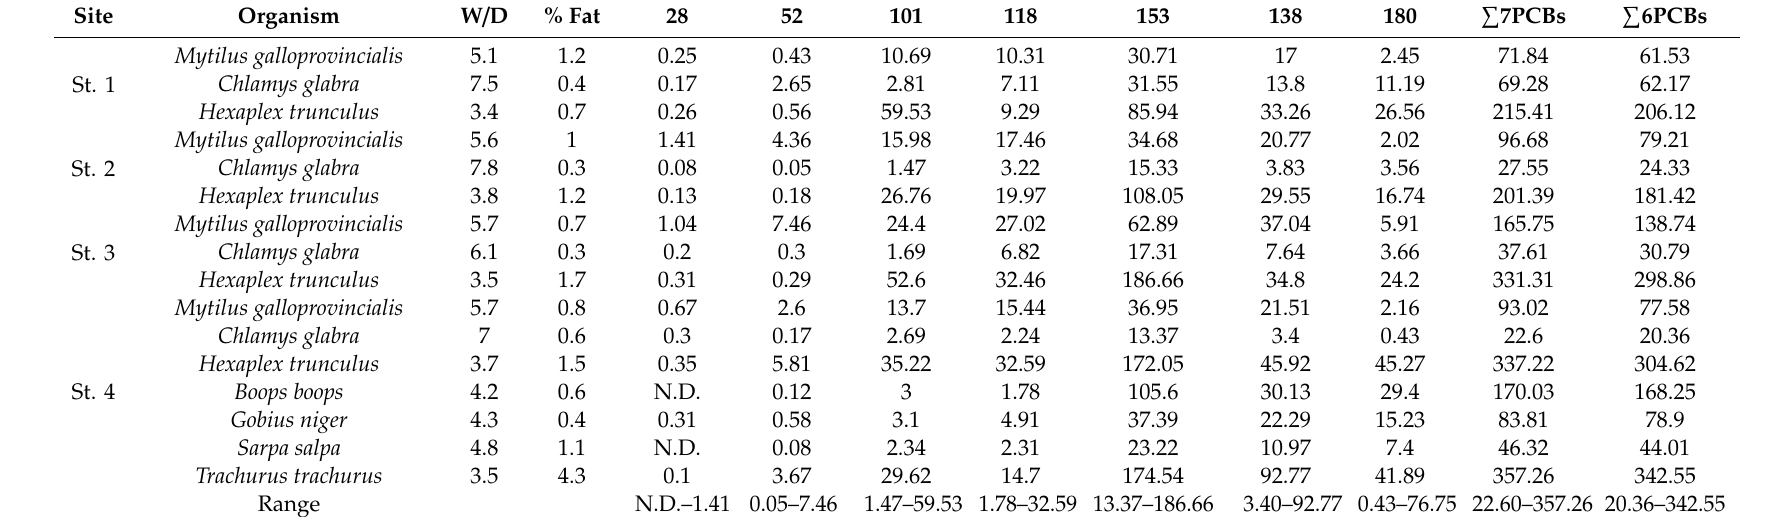
Table 7. Mean values of PCB congeners ( µ g / kg wet weight), wet / dry ratio, and fat content (%) in soft tissues of marine organisms ( n = 3; S.D. range =